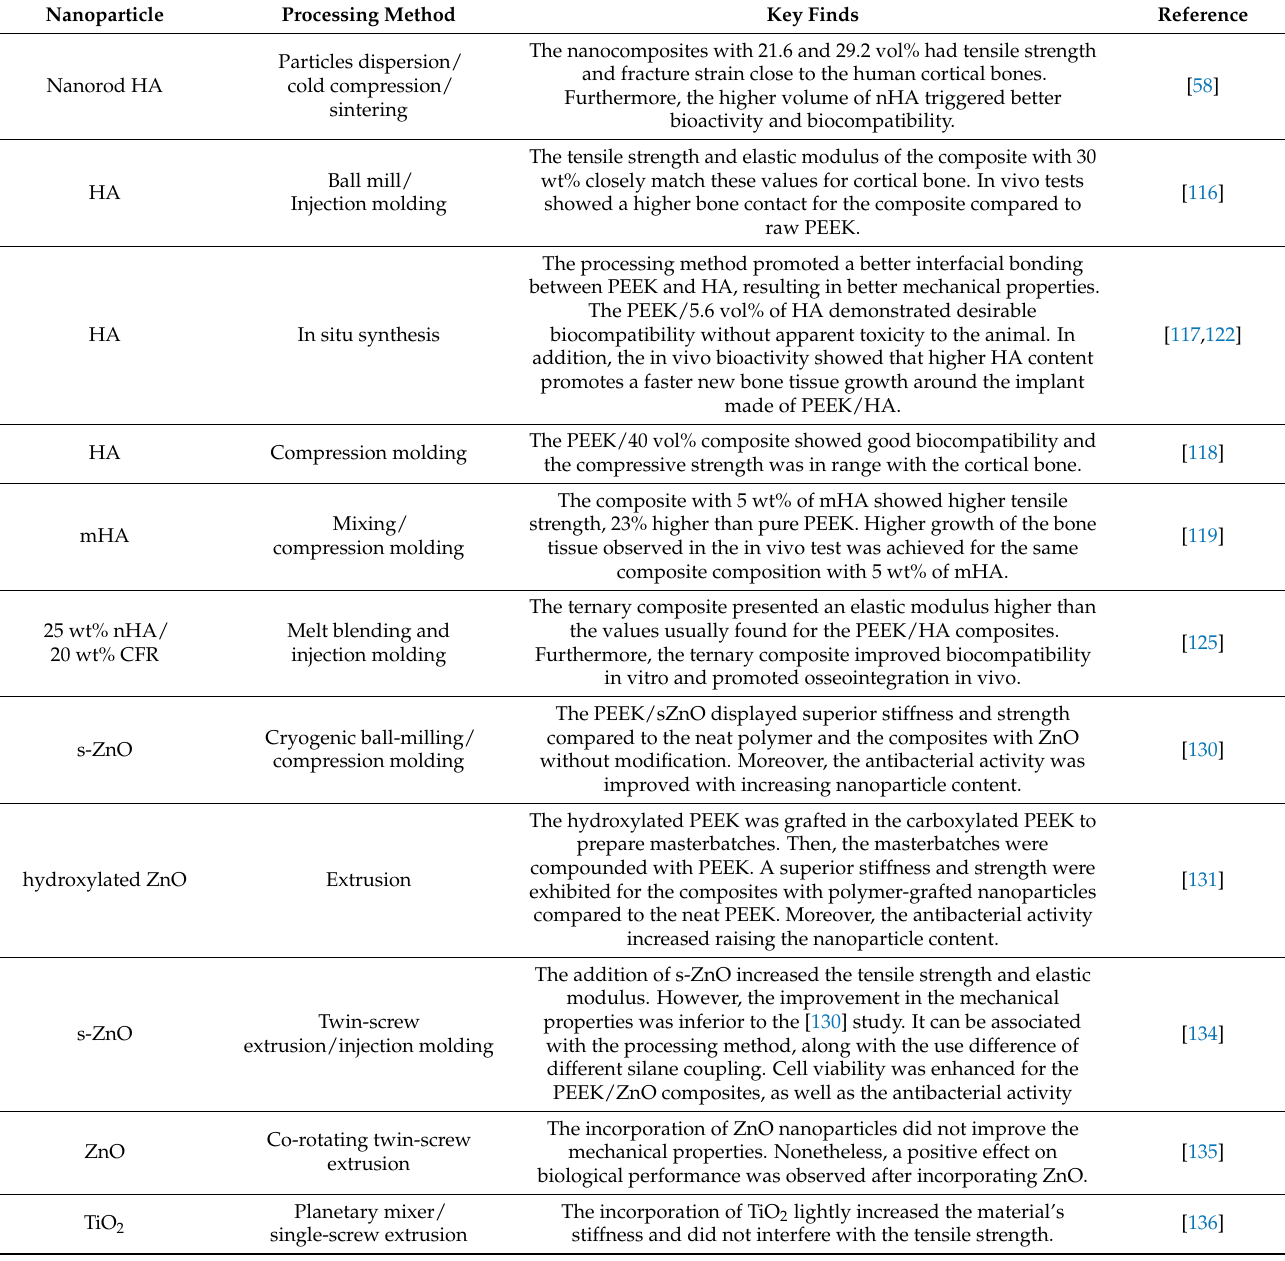
Table 5. List of some reported studies of PEEK